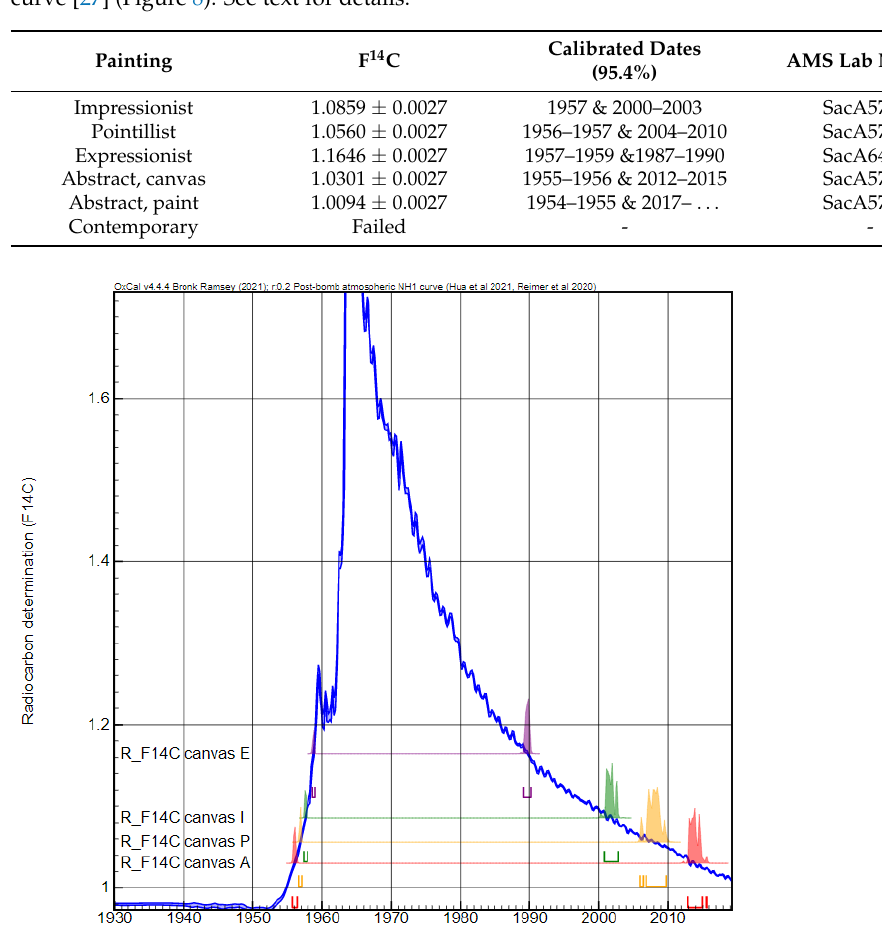
Figure 8. Calibration of the fiber samples taken from the canvas of the Impressionist, Pointillist, Abstract, and Expressionist paintings. The blue curve is the post-bomb atmospheric calibration curve (Bomb13 NH1) used to calibrate 14 C dates after 1950 [25–27]. See text for details.